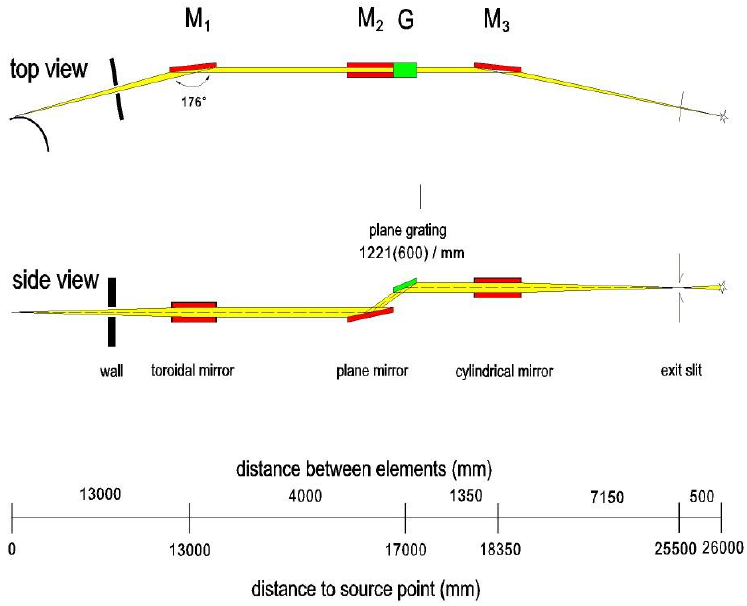
Figure 2: Optical layout of beamline PM3.